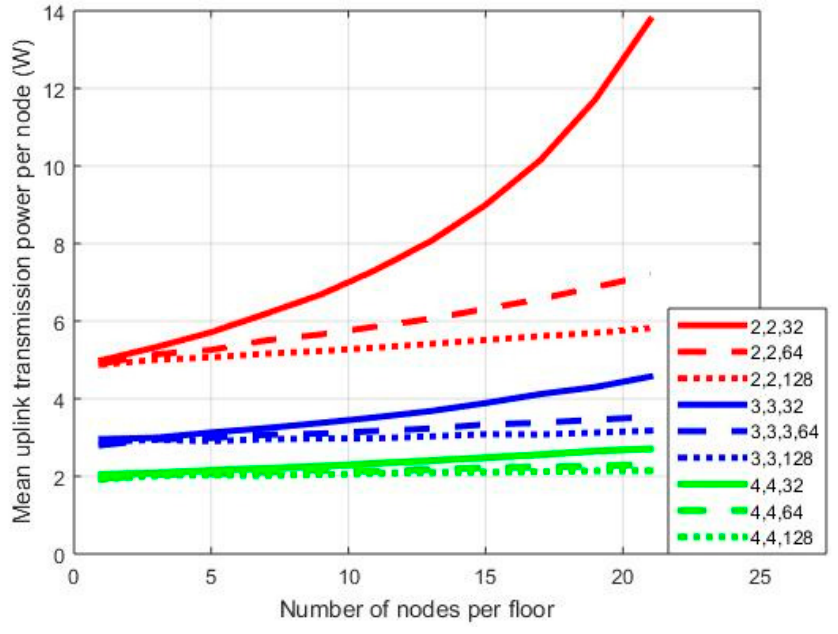
Figure 5 . Mean power per node for SNR = 7 dB. Figure 5. Mean power per node for SNR = 7